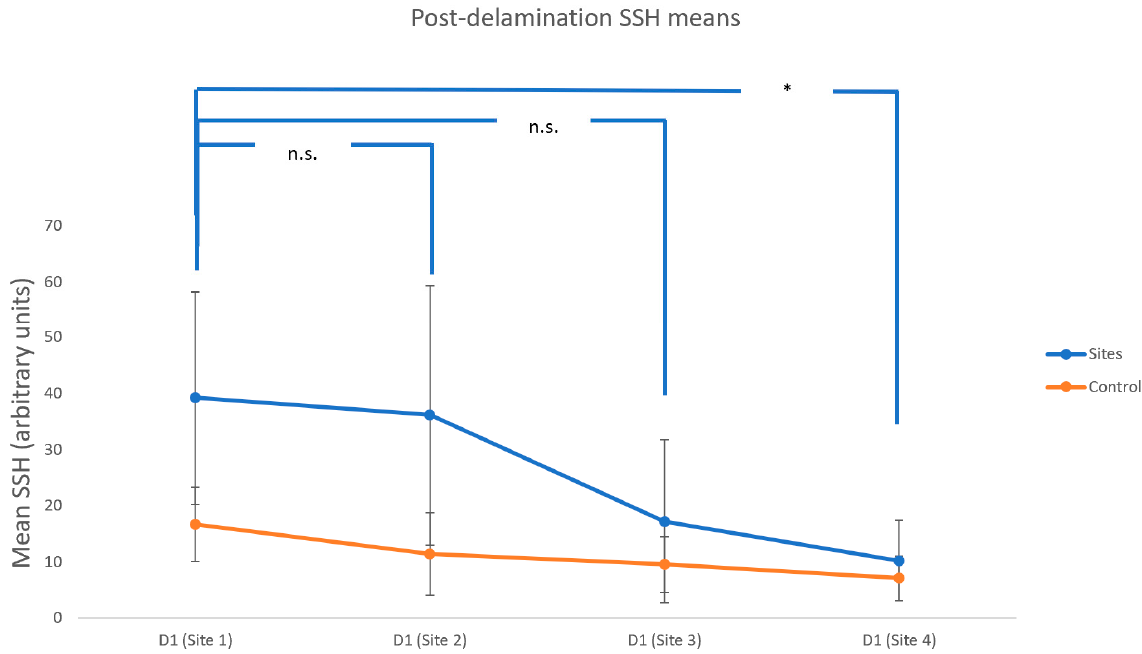
Figure 5. Mean post-delamination skin surface hydration (SSH). The evaluated spot-on was applied at the end of each week (* p < 0.05; n.s. not significantly different from baseline). Error bars represent standard deviation from the